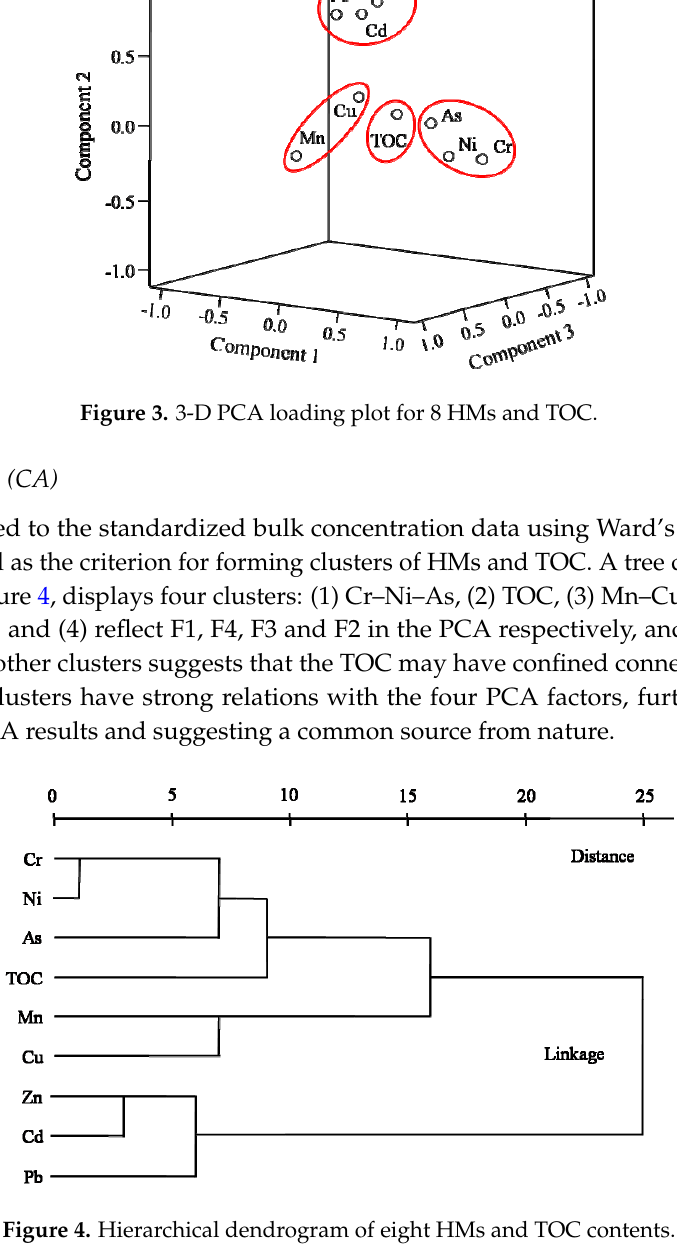
Figure 4. Hierarchical dendrogram of eight HMs and TOC contents.